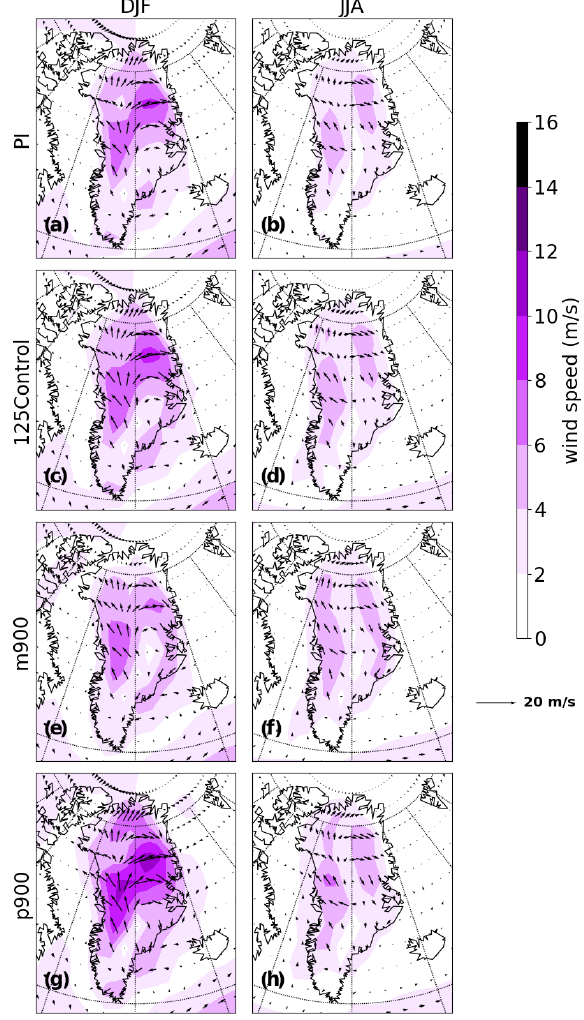
Figure 4. Absolute DJF and JJA low-level winds (at 850hPa) for PI (a–b) , 125Control (c–d) , m900 (e–f) and p900 (g–h) . Shading displays wind speed (ms − 1